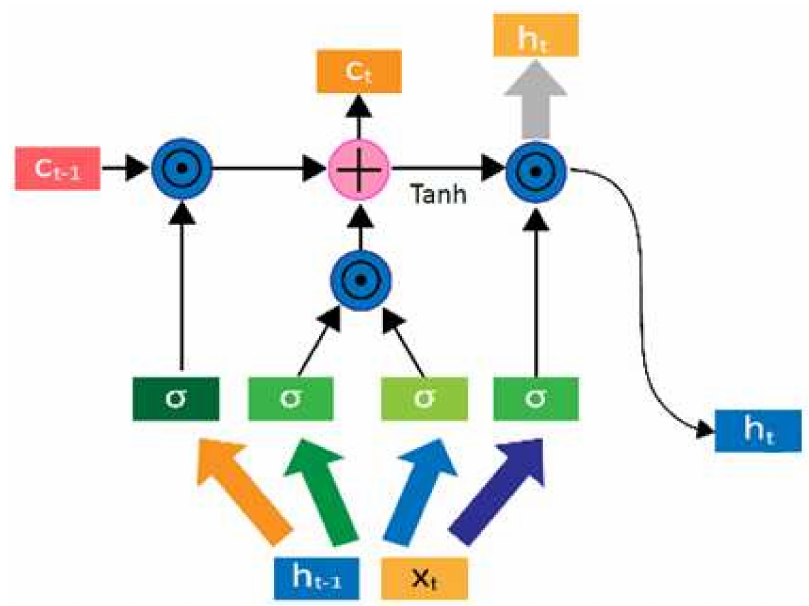
Figure 1. LSTM cell